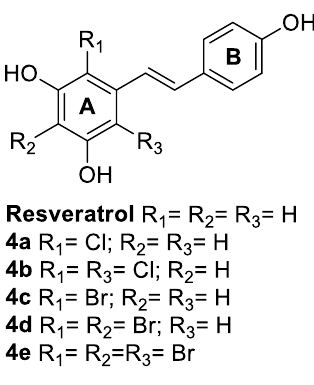
Figure 3. Structures of halogenated resveratrol derivatives from Li et al. (2012) [59]. Table 6. MIC of some halogenated resveratrol derivatives from Li et al. (2012) [59]. MIC (µg/mL) Compound